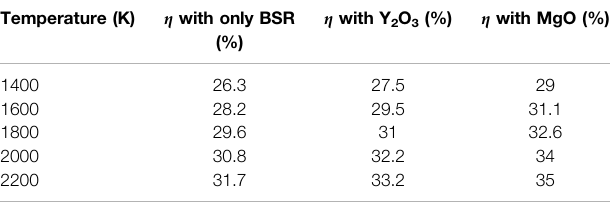
TABLE 3 | Spectral technology – wise ef fi ciency improvement; ( η at the emitter temperatures of 1400, 1600, 1800, 2000, and 2200 K). Temperature (K)